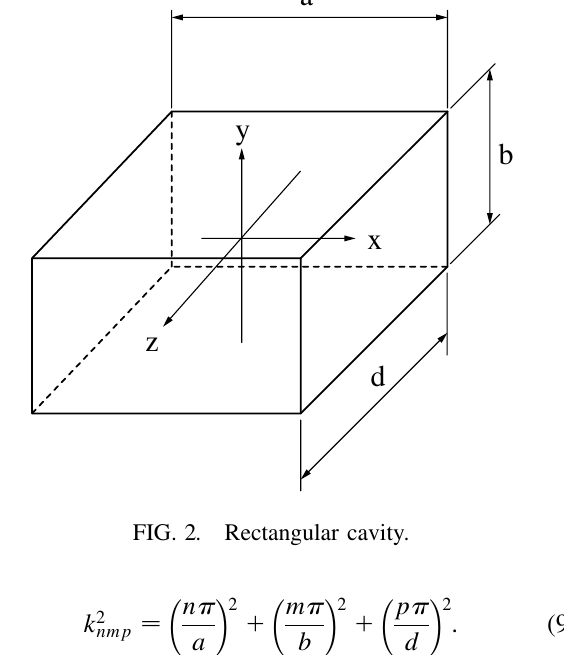
FIG. 2. Rectangular